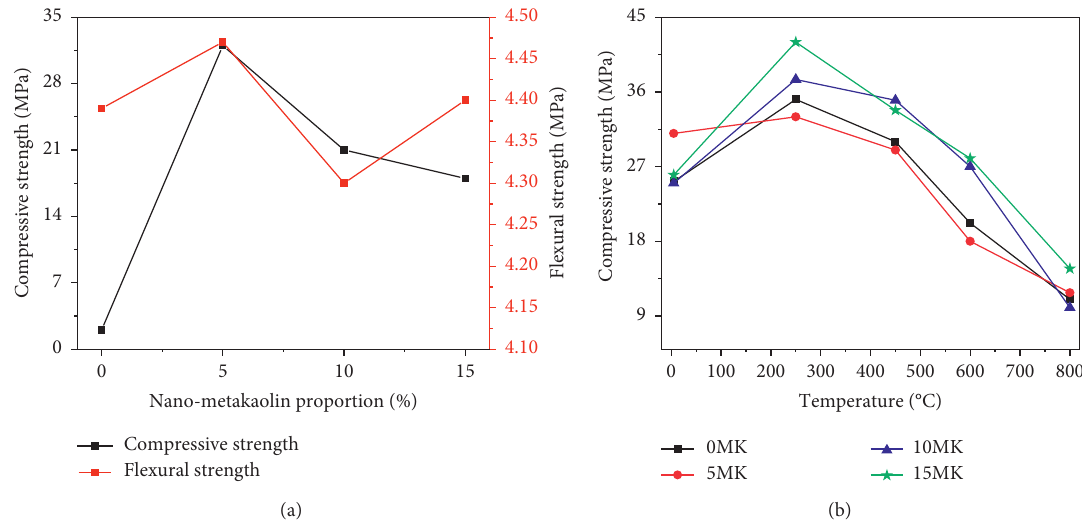
Figure 22: Compressive and flexural strength of NMK-cement mortar and NMK proportion and temperature [120]. (a) Different contents of NMK. (b) Different